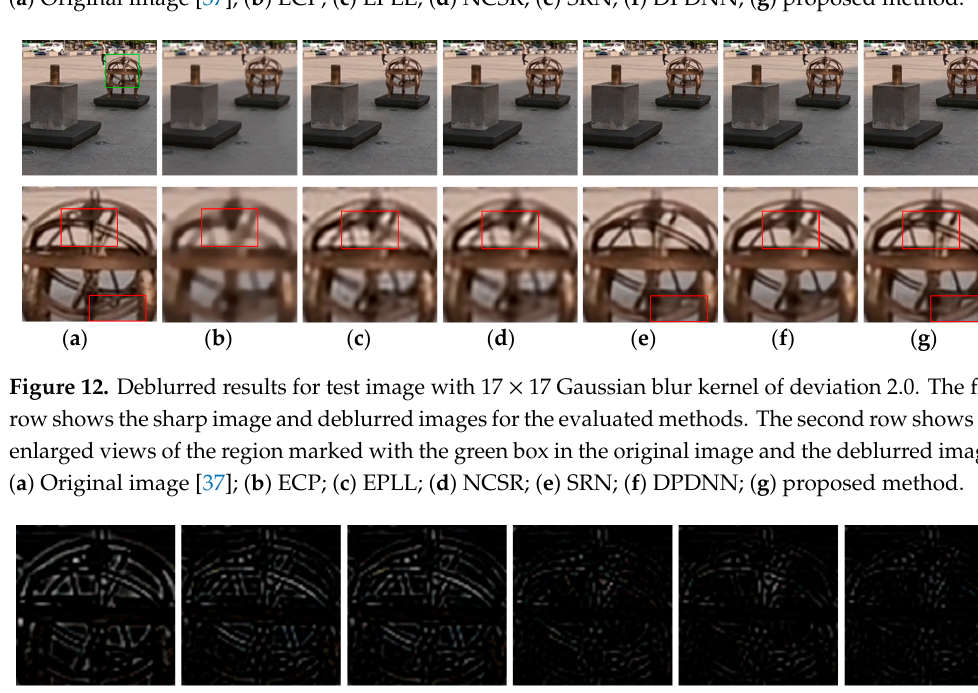
Figure 11. Deblurred results for test image with 17 × 17 Gaussian blur kernel of deviation 1.8. The first row shows the sharp image and deblurred images for the evaluated methods. The second row shows the enlarged views of the region marked with the green box in the original image and the deblurred images. ( a ) Original image [37]; ( b ) ECP; ( c ) EPLL; ( d ) NCSR; ( e ) SRN; ( f ) DPDNN; ( g ) proposed method.